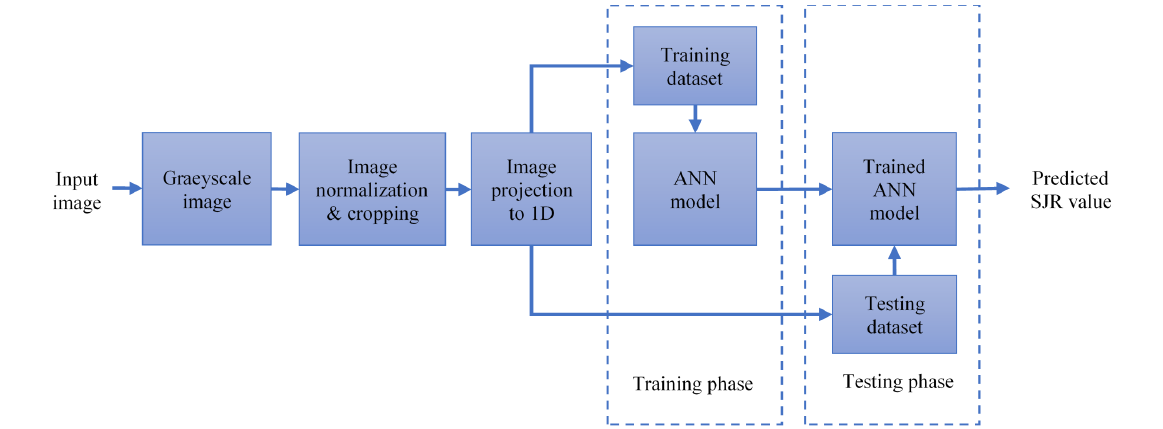
Figure 15. Block diagram of SJR estimation algorithm.